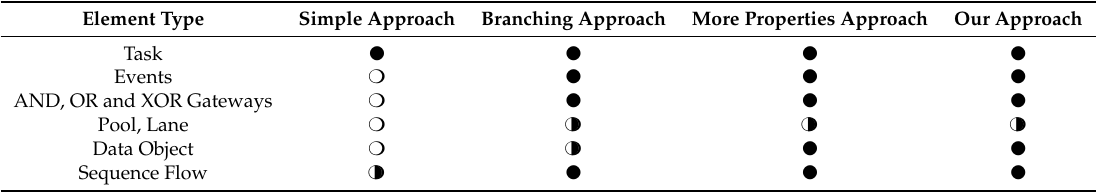
Table 19. Comparison to the existing spreadsheet-based approaches (introduced in [26,27]) in terms of supporting various business process